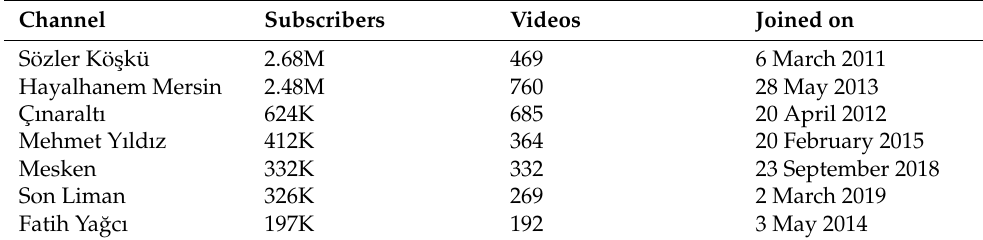
Table 2. Islamic YouTube channels and Muslim male YouTubers in Turkey.